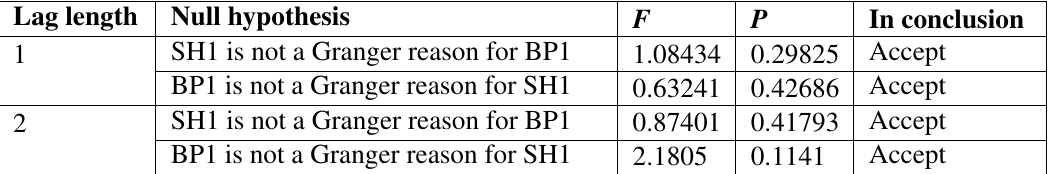
Table 1 SH1 and BP1Granger causality test